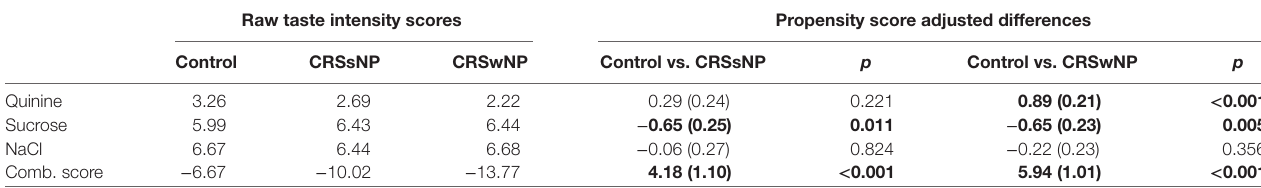
Significant values are shown in bold.